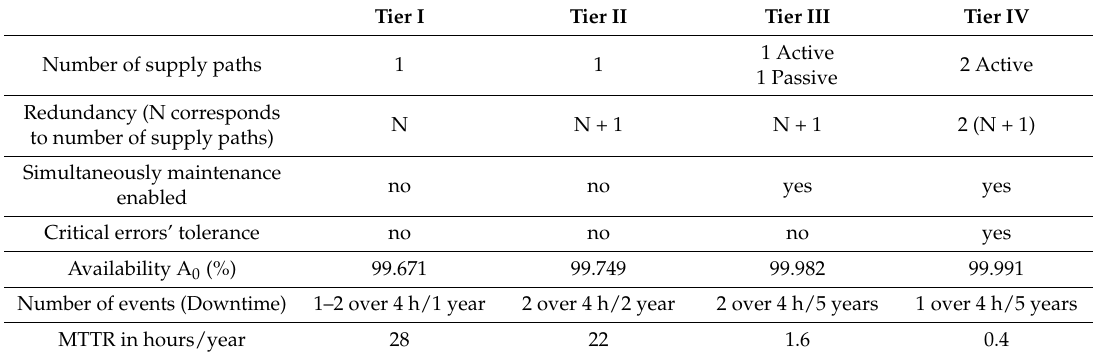
Table 1. Tier classification